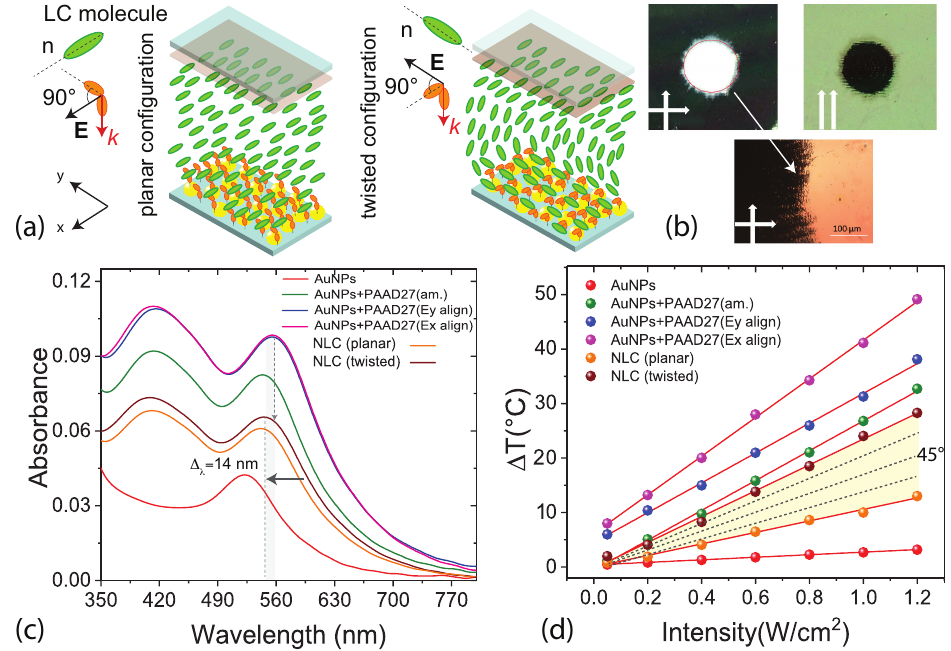
Figure 3. ( a ) Sketch of the AuNPs+PAAD-27+NLC cell in planar and twisted configuration. ( b ) POM view of the planar (left and right images, outside the red circle) and twist (left and right images, inside the red circle) alignment along with a high magnification of the transition zone (from planar to twist, bottom photo) of the sample. Left and right images have been acquired between crossed and parallel polarizers, respectively. ( c ) Absorbance of the AuNPs monolayer in air, covered by PAAD-27 and with NLC; ( d ) Photo-thermal response of the sample in air and after the deposition and alignment of PAAD-27 and the infiltration and photo-alignment of NLC.